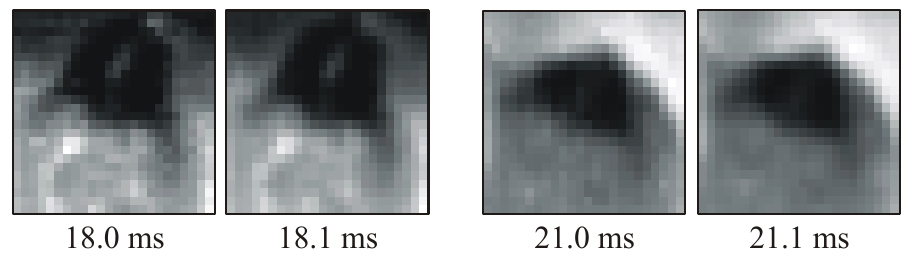
Figure 2. Neighbored image patterns at the 18 th and 21 st